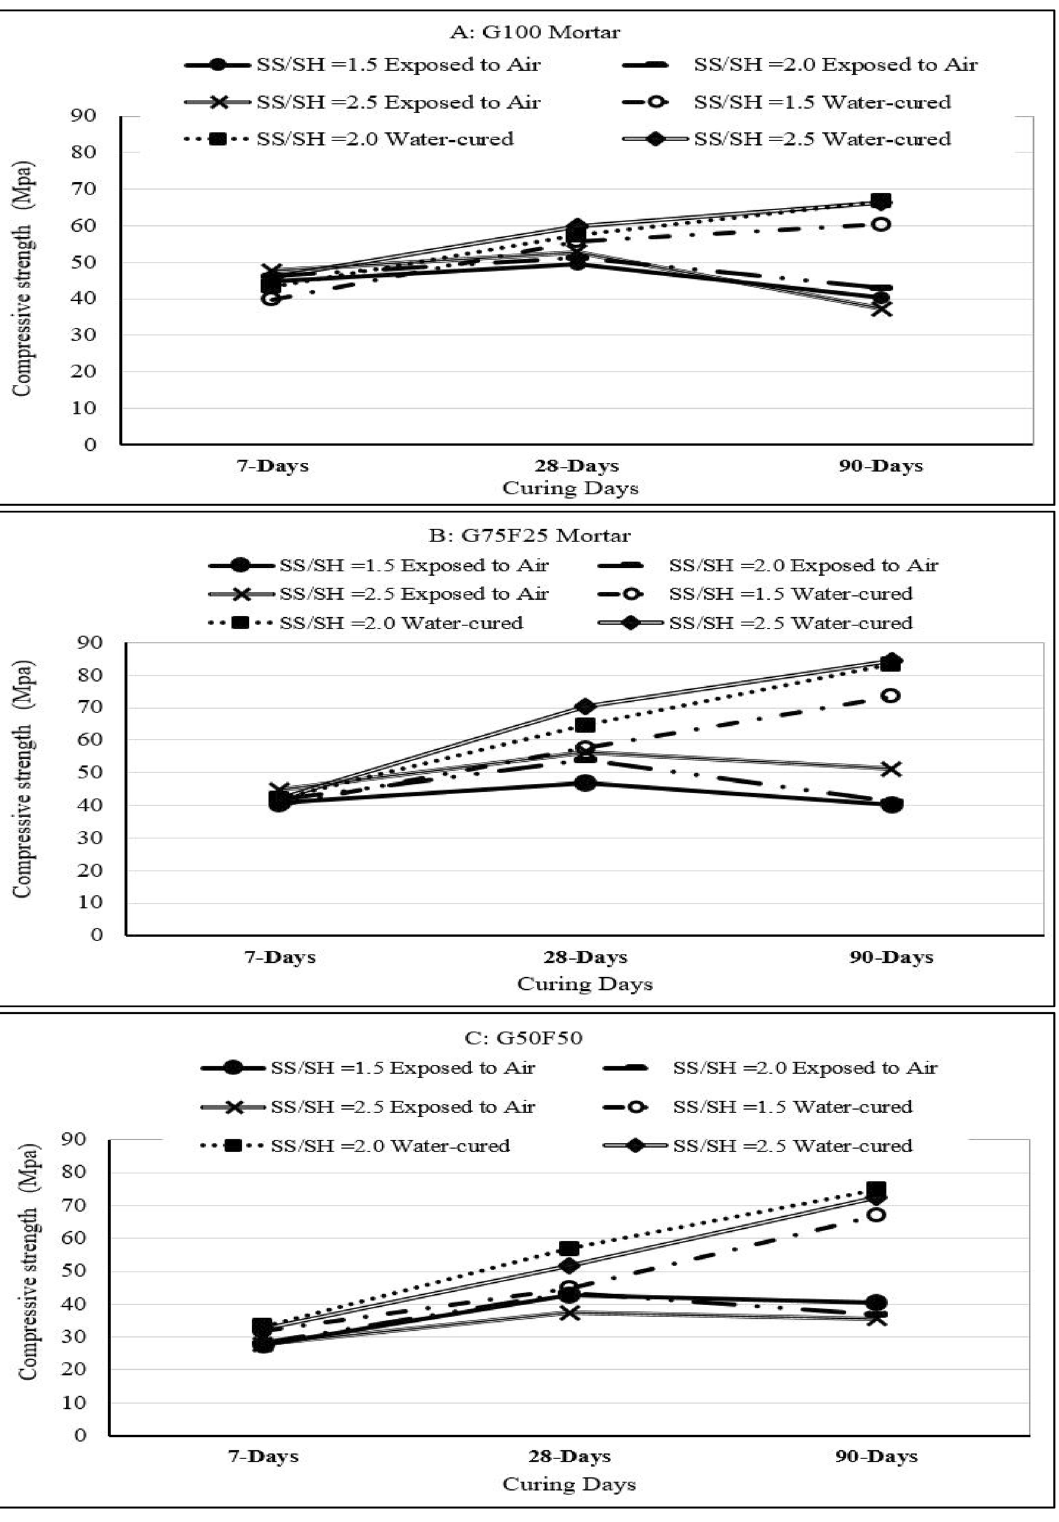
Figure 6. Effect of activator sodium silicate/sodium hydroxide ratio on strength development for mortars with binders consisting of: ( A ) GGBS as sole binder (G100), ( B ) GGBS: fly ash ratio of 3:1 (G75F25), and ( C ) equal amounts of GGBS and fly ash